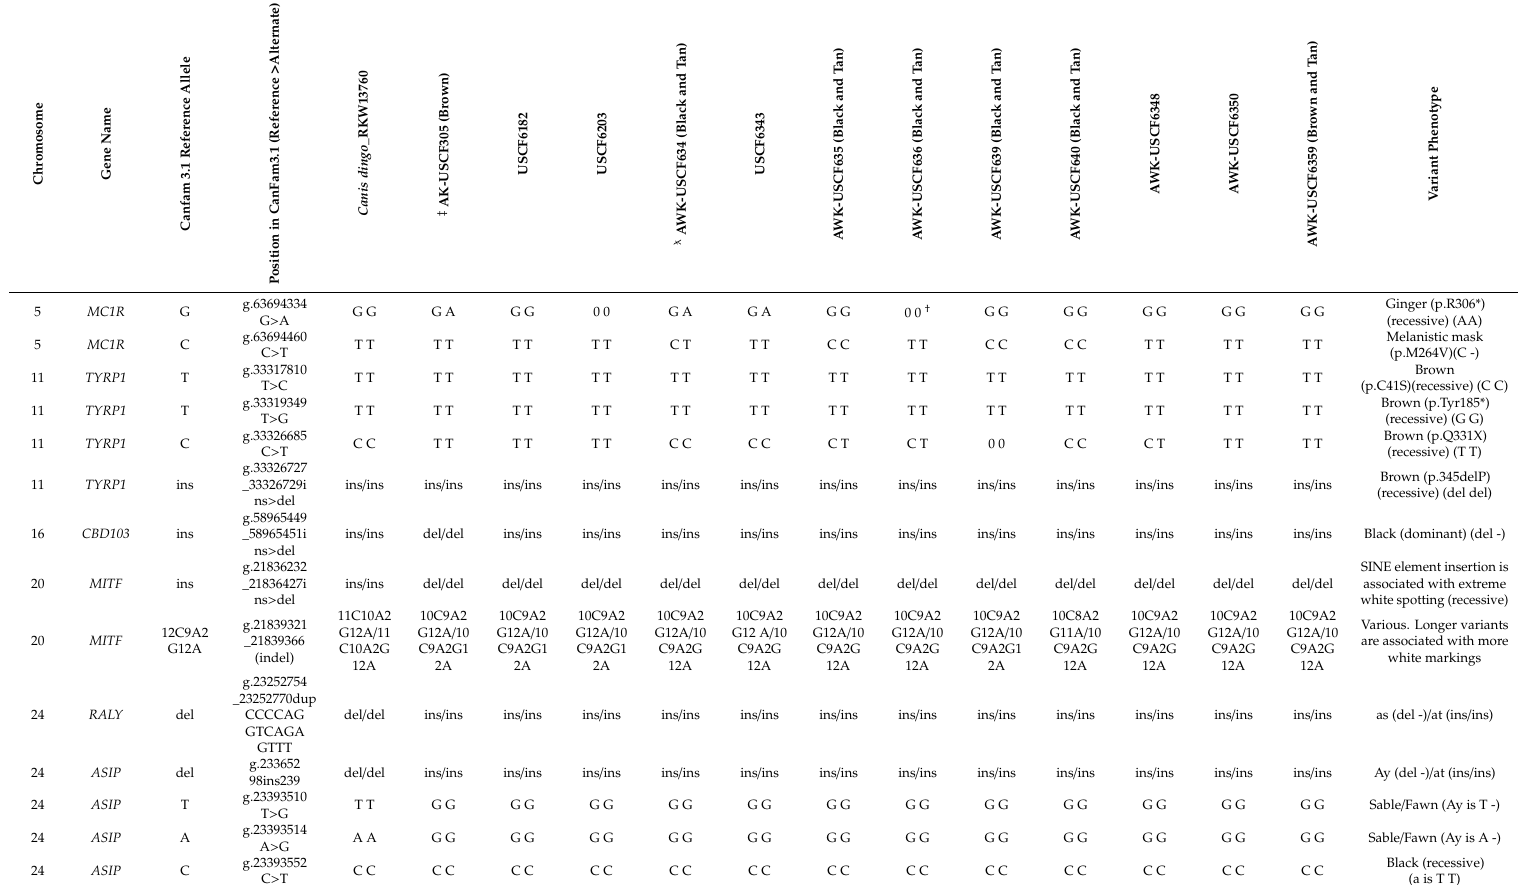
Table 2. Observed segregation of major coat color variants in 12 Kelpies and one Dingo. Owner-declared coat colors in